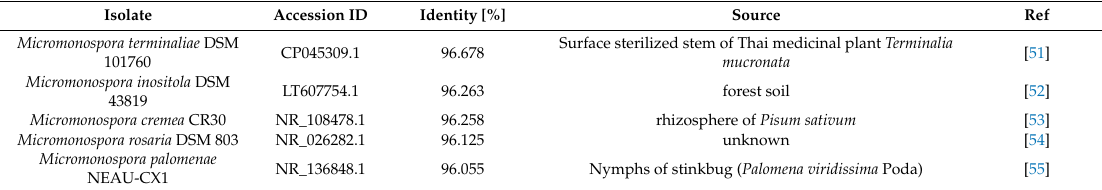
Table 1. List of validly published strains of genus Micromonospora. Identity calculated against strain Micromonospora sp. UA17.